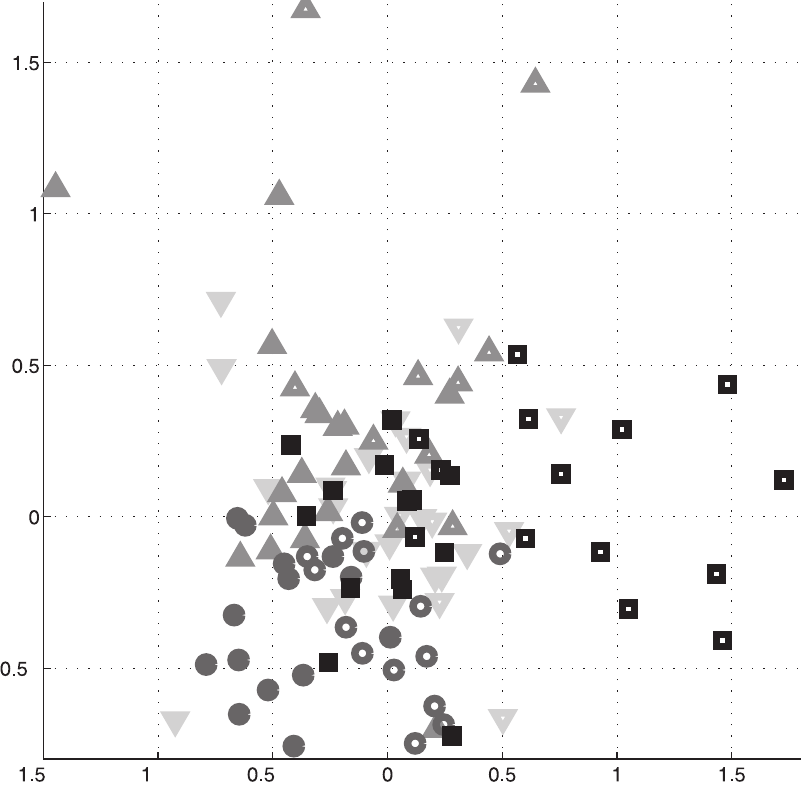
Figure 6. Representation of global MDS. Downward-pointing triangle: TalFr; upward-pointing triangle: TalFox; circle: gICA; square: indICAs. Hallow symbols stand for the rest condition, full ones for the task condition.